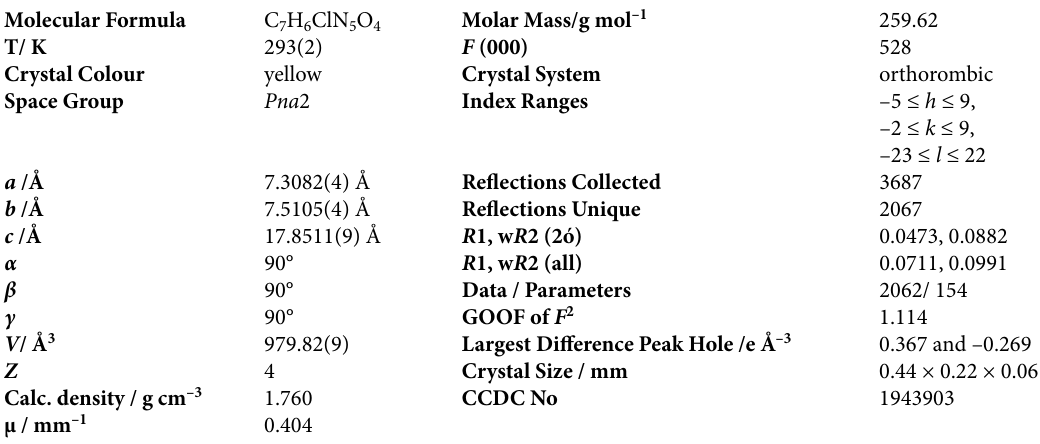
Table 3. N -(5-chloro-2,4-dinitrophenyl)guanidine ( 2 ) crystal data and data collection conditions.